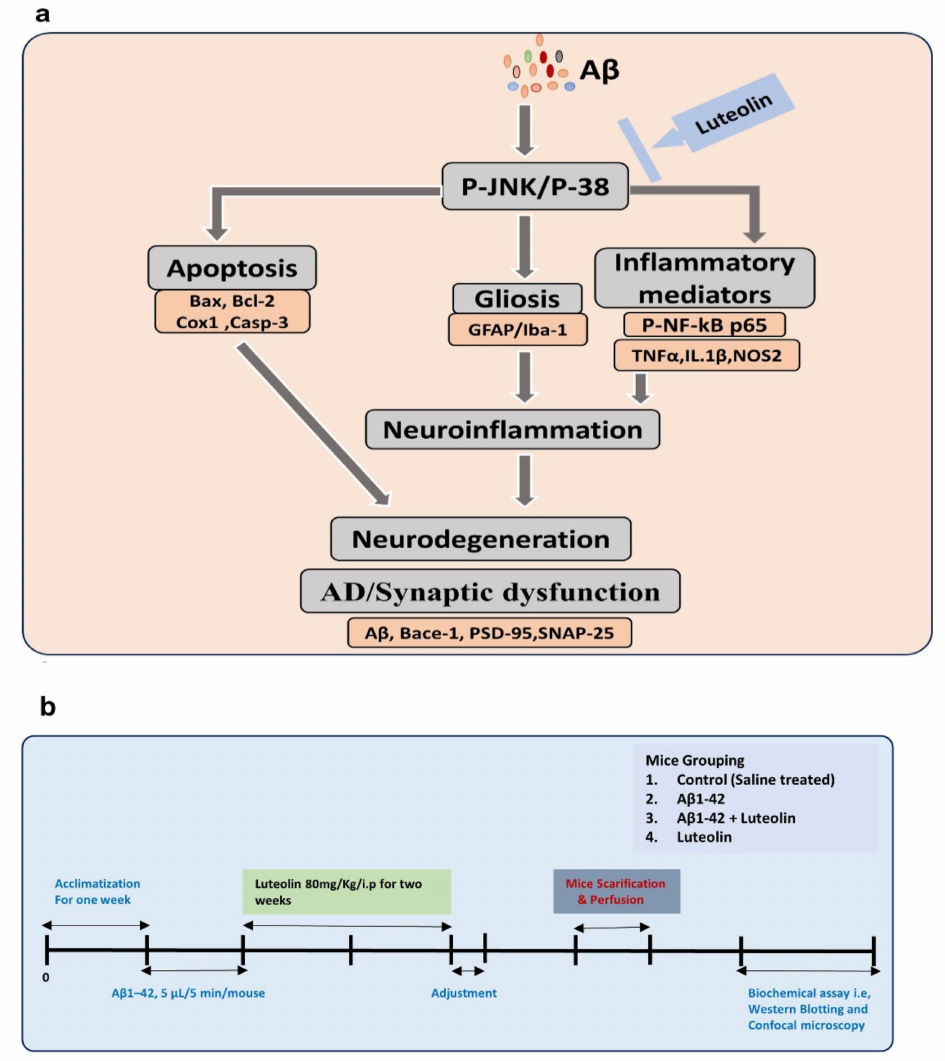
Figure 1. Graphical Abstract and Study design. ( a ) Proposed hypothesis and ( b ) study